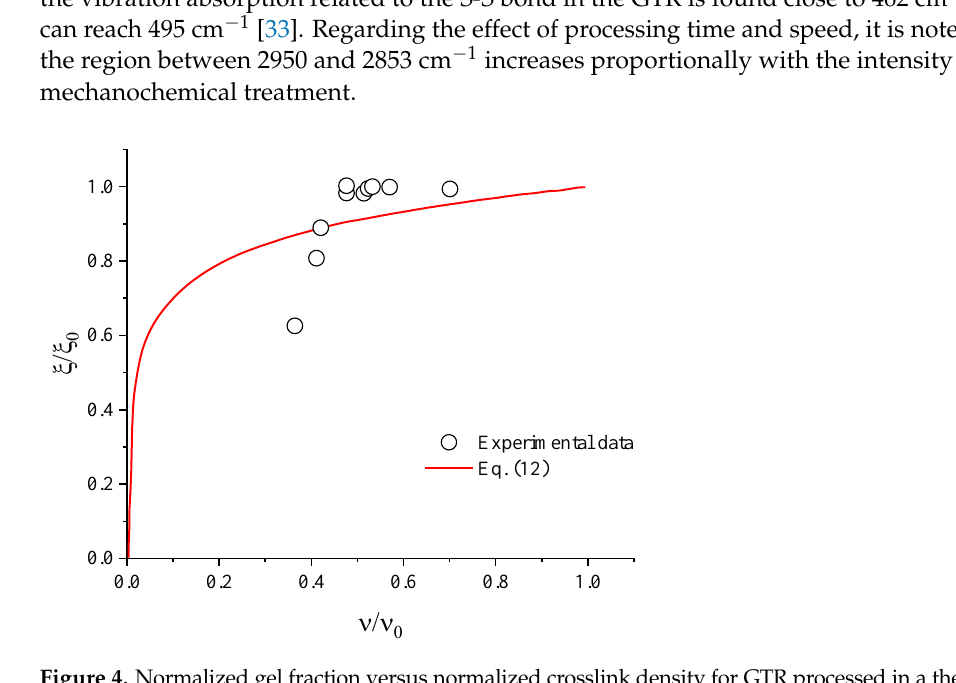
Figure 4. Normalized gel fraction versus normalized crosslink density for GTR processed in a thermokinetic mixer. Symbols are experimental data, and the solid line in red is the fit of Equation (12).